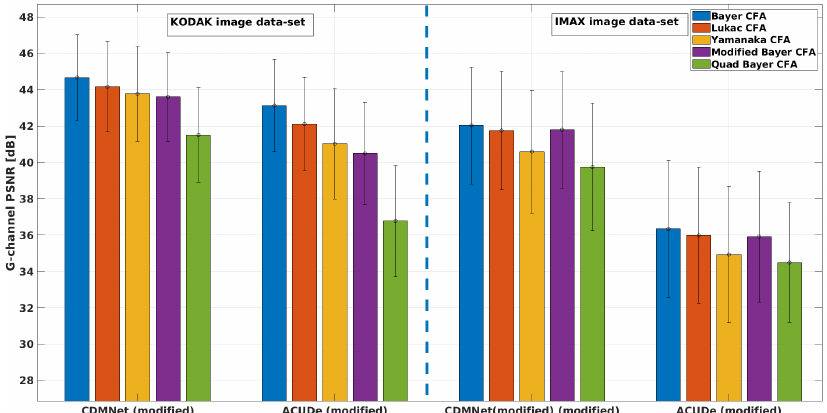
Figure 7. Average PSNR (green channel) results with standard deviation of the mean: for the two modified generic algorithms (“CDMNet modified” and “ACUDe modified”), for the two data-sets (“KODAK” and “IMAX”), for five different Bayer-like patterns (Bayer, Lukac, Yamanaka, Modified Bayer and Quad Bayer).